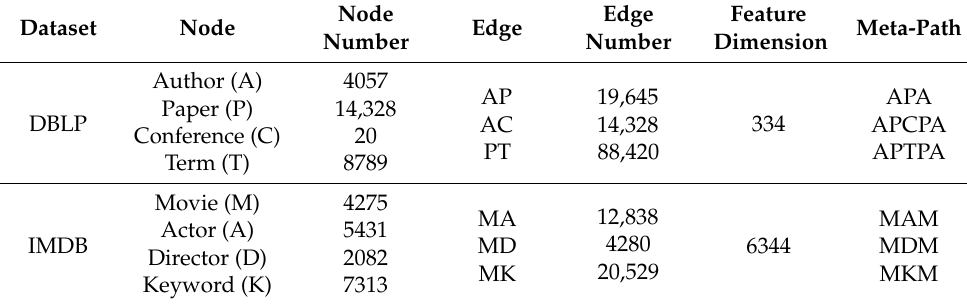
Table 1. Dataset summary